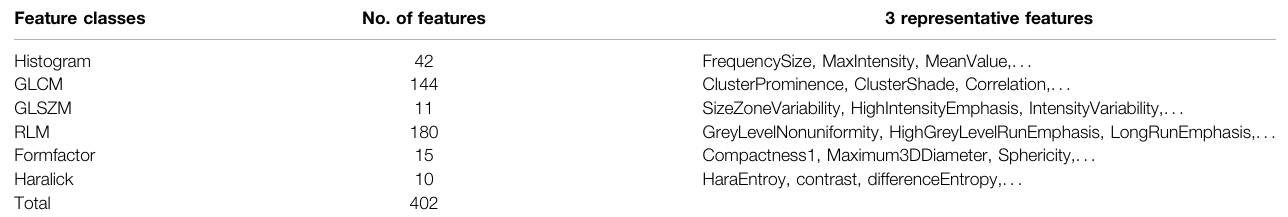
TABLE 1 | Summary of radiomics features used in this study.